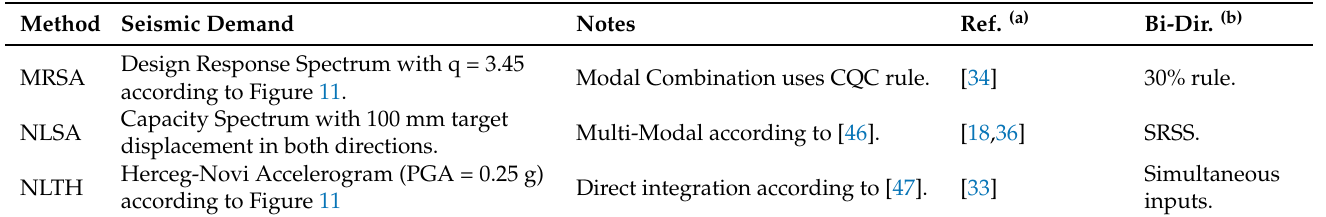
Table 2. Details for structural analyses.